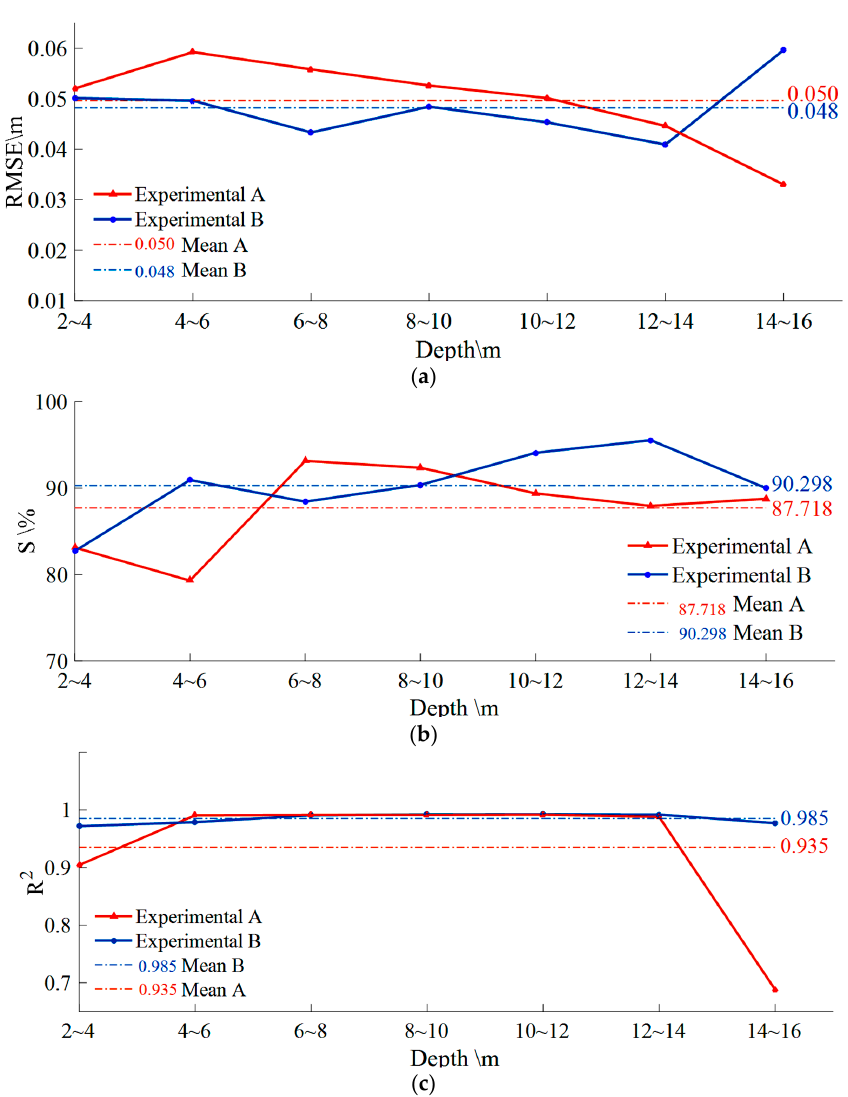
Figure 15. Performance of the GHPD method in Experimental areas A and B: ( a ) the performance of the RMSEs; ( b ) the success rate; ( c ) R-squared (R 2 ) represents the fitness of the depth.